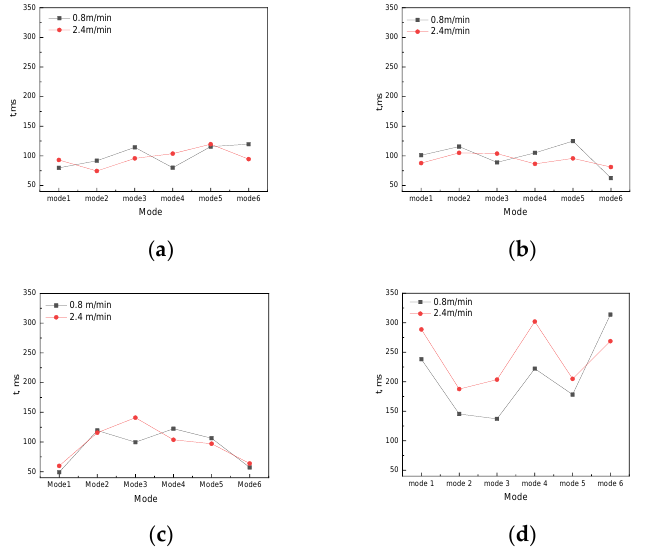
Figure 11. Duration of CHJ and CHJ to HJT of different laying modes. (( a ) CHJ, with solidification; ( b ) CHJ to HJT, with solidification; ( c ) CHJ, without solidification; ( d ) CHJ to HJT, without solidification). The law of duration for the three transition processes of hydraulic jump (CHJ, HJT, and SLL) with solidification is similar to that without solidification (Figure 11).